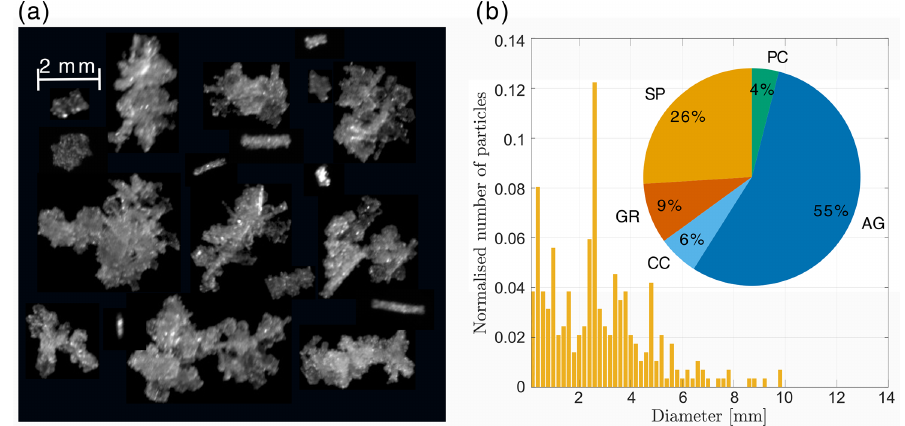
Figure 14. Same as Fig. 8 for the period 10:00 to 11:00UTC. The number of particles is 69. The average temperature is 0.0 ◦ C (Fig.